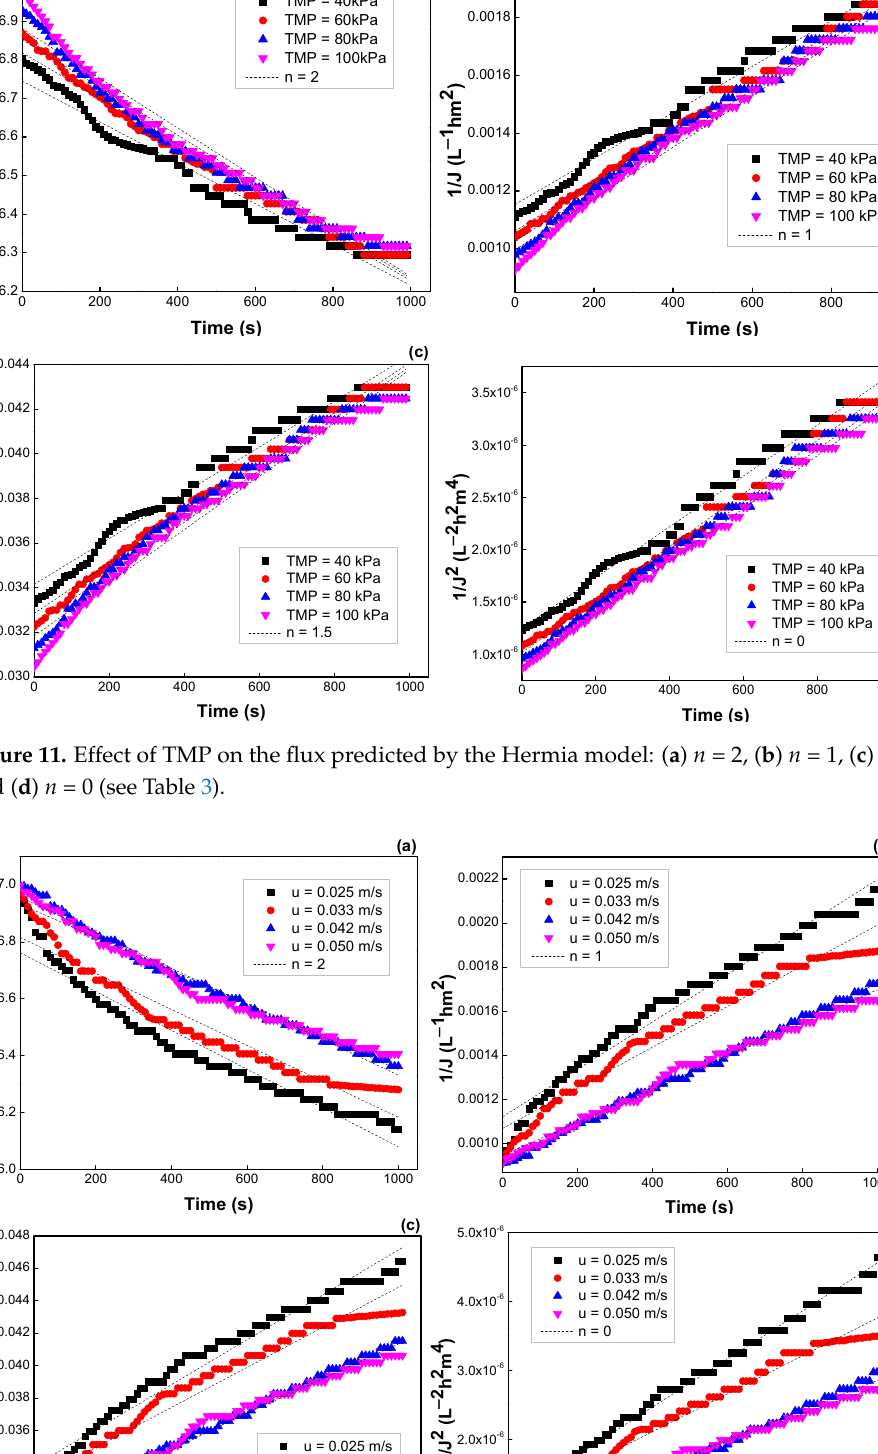
Table 5. R 2 values and K constants in the Hermia model at different TMPs.